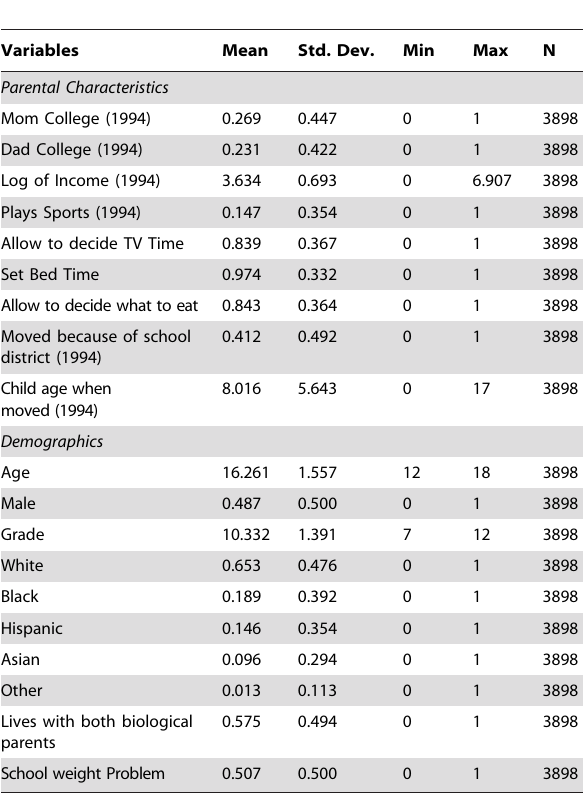
Table 1. Descriptive Statistics (Adolescents from Add Health Wave II/1996).